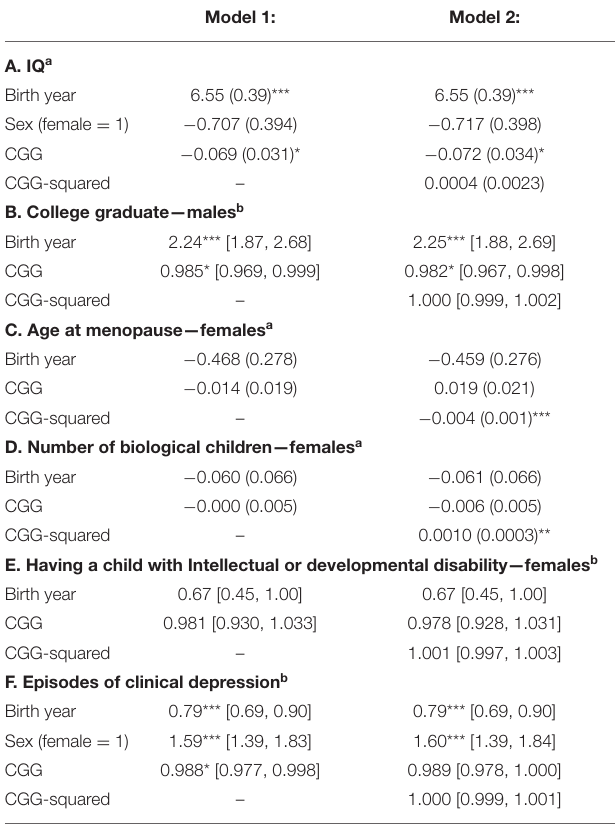
TABLE 2 | Associations between CGG repeat length and phenotypes. Model